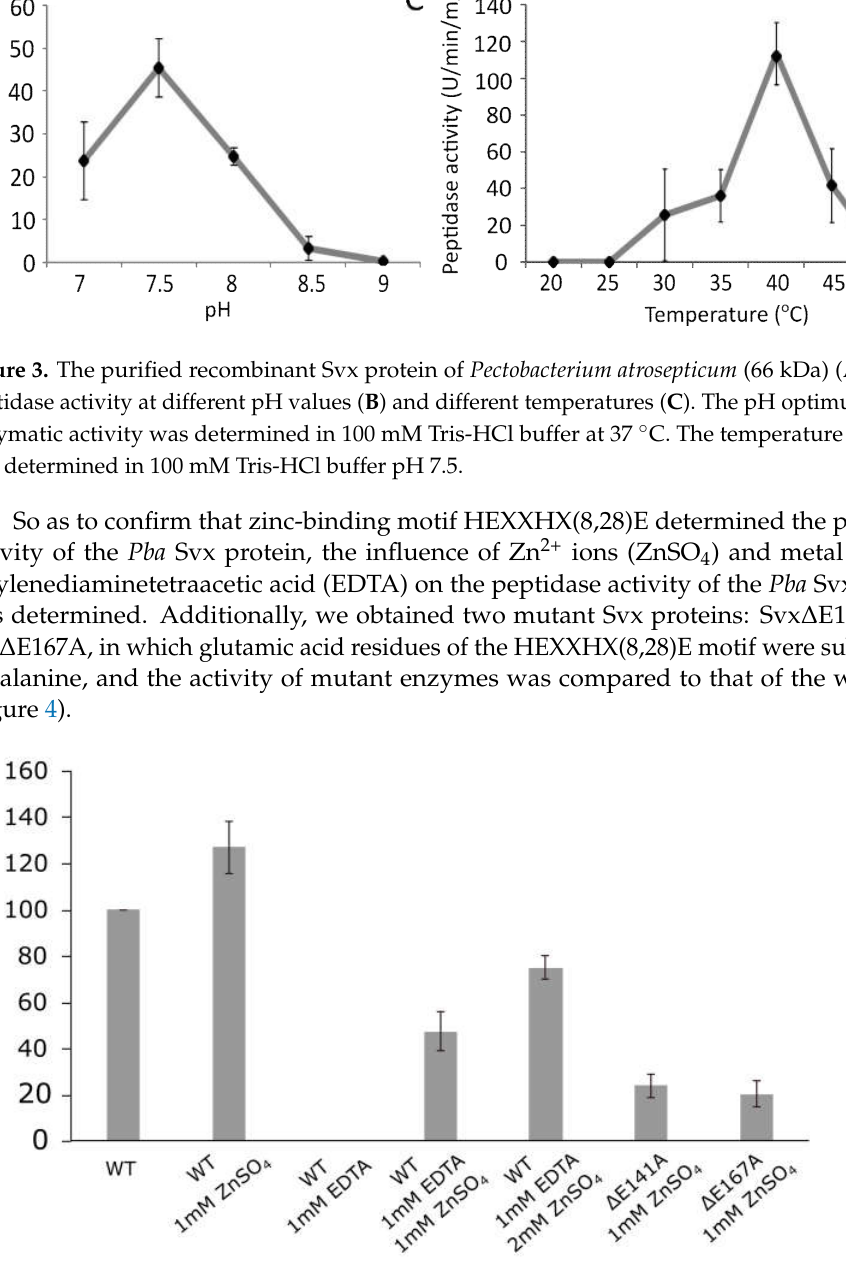
Svx ∆ E167A displayed 3.1- and 3.5-fold lower peptidase activity, respectively,